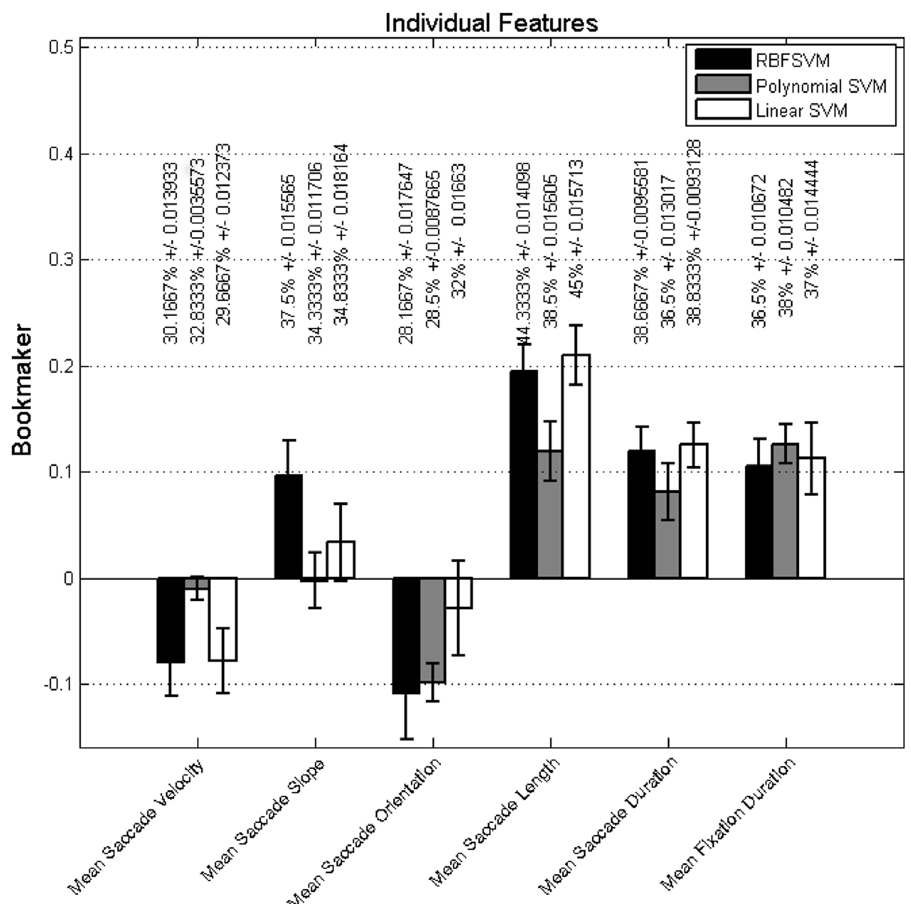
Fig 5. Baseline mean performance for mean value features in terms of bookmaker for classification of images into three class of unpleasant, neutral, and pleasant. The mean of classification accuracy across folds and repetitions (%) and their associated standard errors are also added to each bar as a second measurement unit.